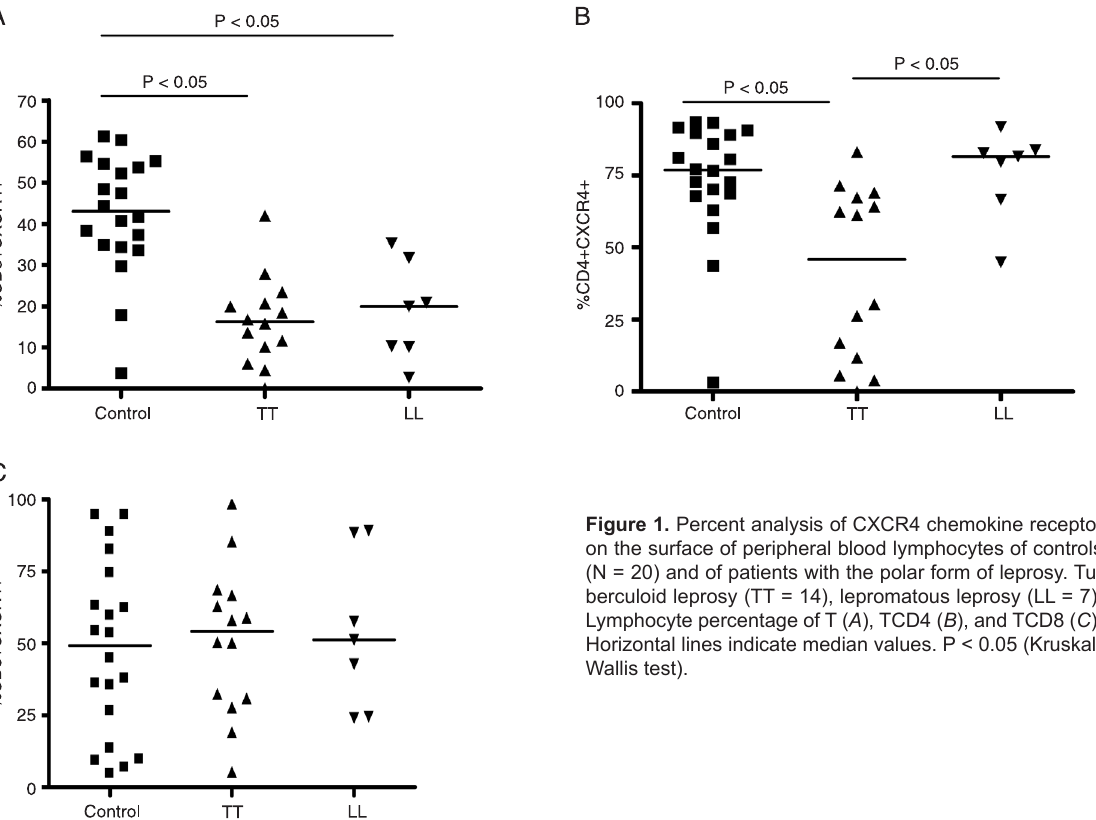
Figure 1. Percent analysis of CXCR4 chemokine receptor on the surface of peripheral blood lymphocytes of controls (N = 20) and of patients with the polar form of leprosy. Tu- berculoid leprosy (TT = 14), lepromatous leprosy (LL = 7). Lymphocyte percentage of T ( A ), TCD4 ( B ), and TCD8 ( C ). Horizontal lines indicate median values. P < 0.05 (Kruskal- Wallis test).